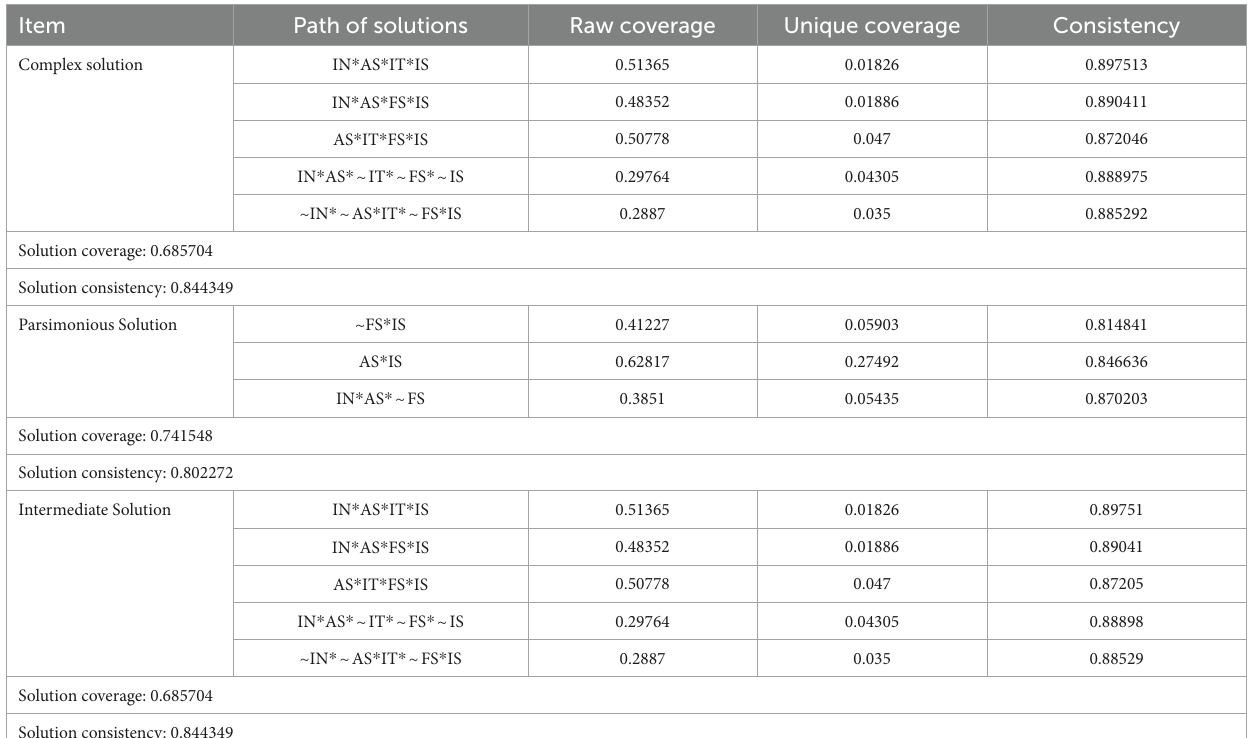
TABLE 7 Complex solution, parsimonious solution, and intermediate solution.